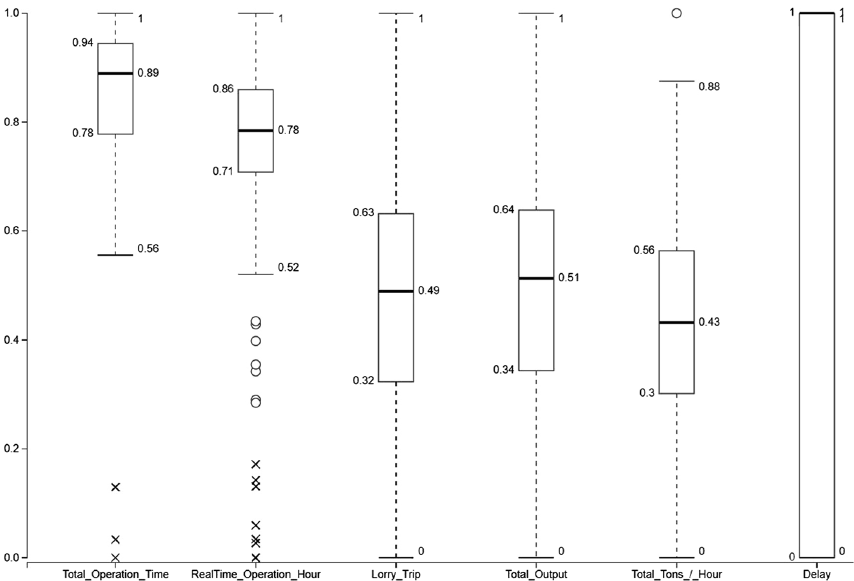
Fig. 6 Boxplot illustrating basic statistics and outlier of the production